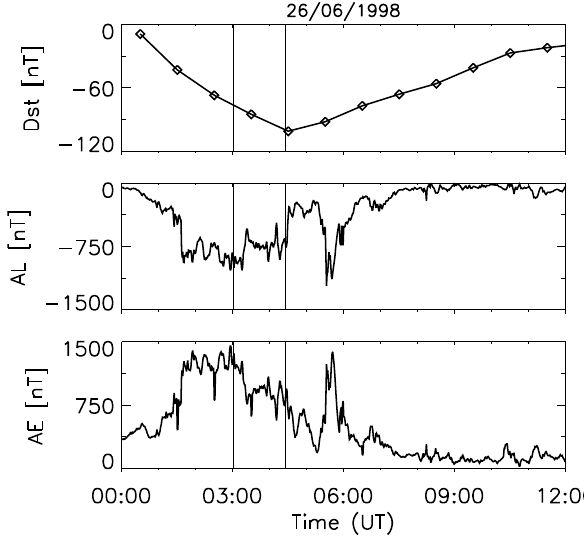
Fig. 5. The AE, AL and D st -indices between 00:00 and 12:00 UT on 26 June 1998. The two vertical solid lines indicate our time interval with data between 03:00 and 04:15 UT.